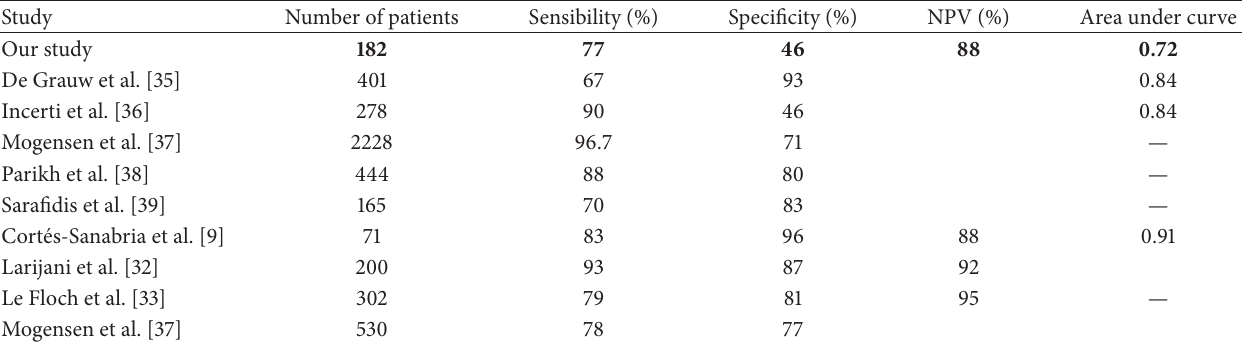
Table 4: Micral-test’s validity in literature.